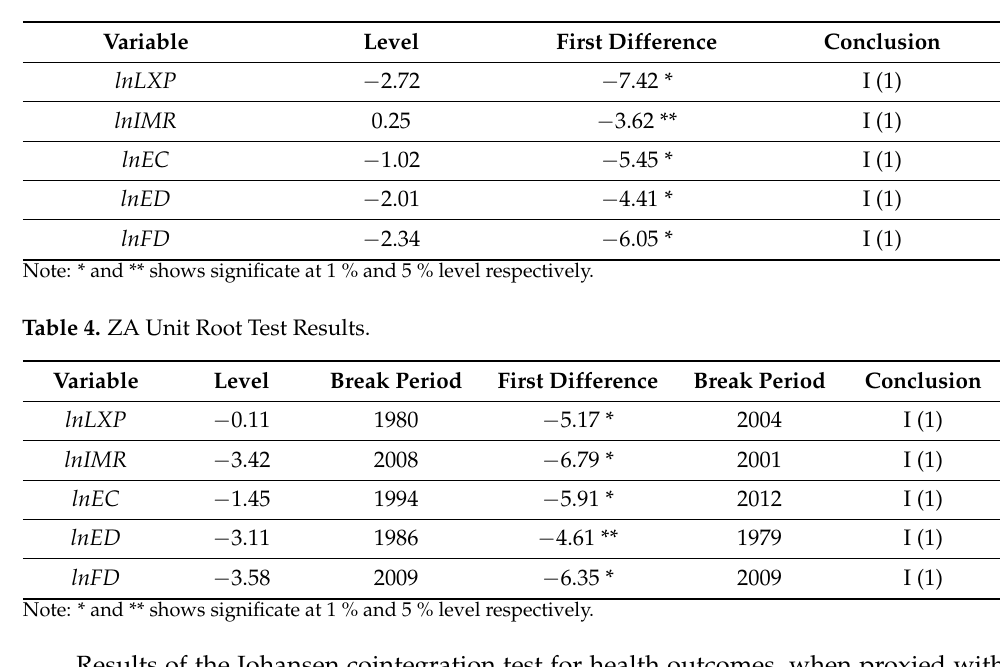
Table 3. ADF Unit Root Test Results.